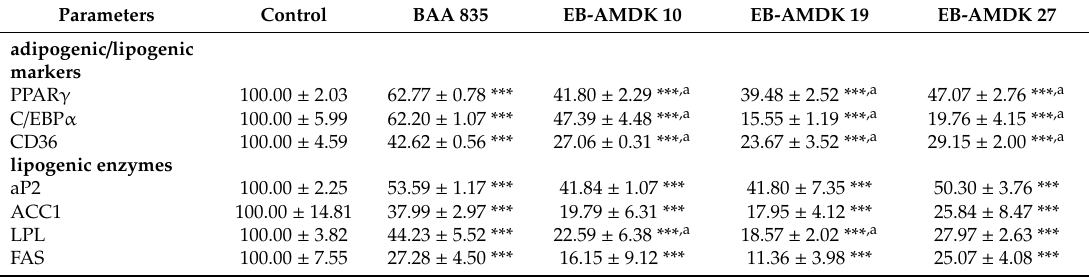
Table 1. Impact of three selected A. muciniphila strains on the expression of the adipogenic and lipogenic genes in 3T3-1 adipocytes.